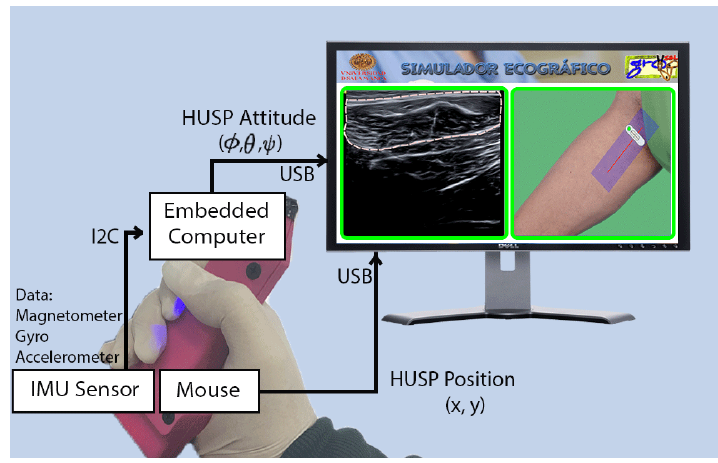
Figure 8. Global scheme of the US probe-based training